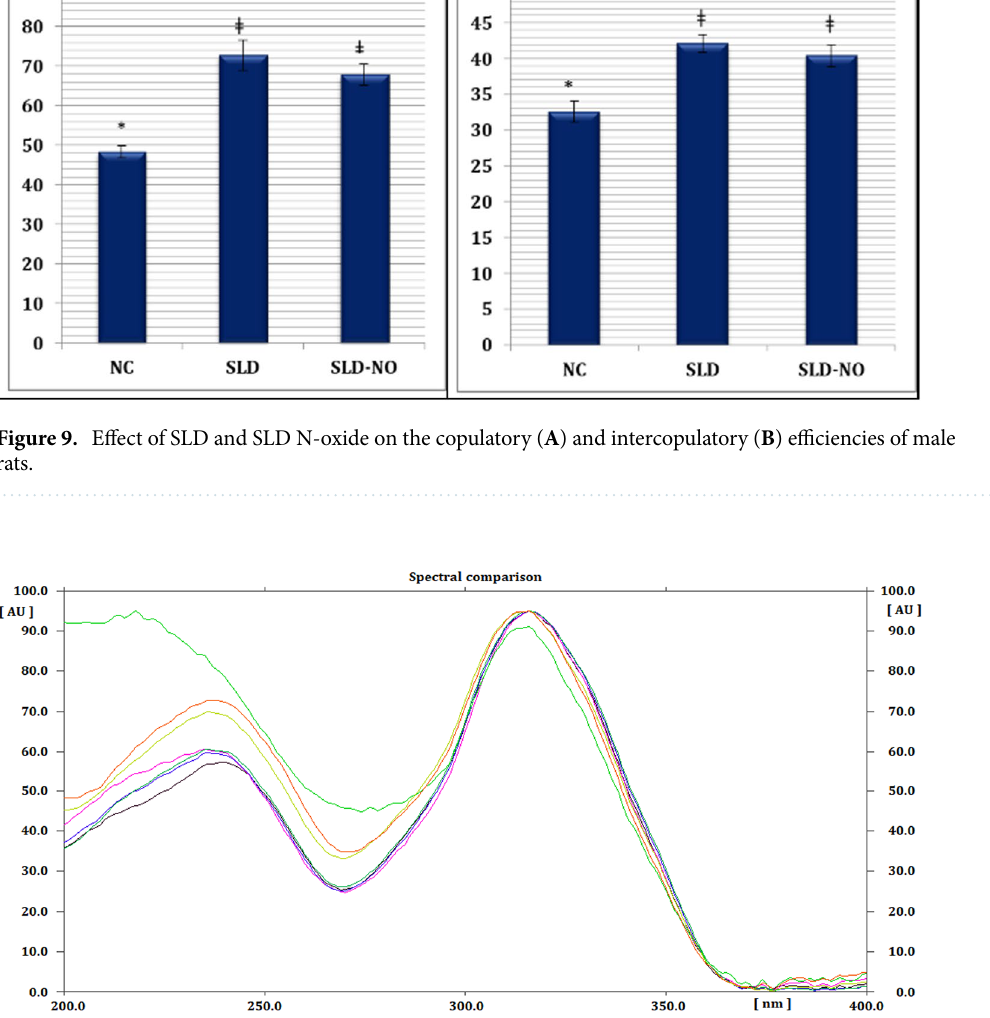
Figure 10. Overlay UV absorption spectra of standard SLD and acid, base, hydrogen peroxide and different